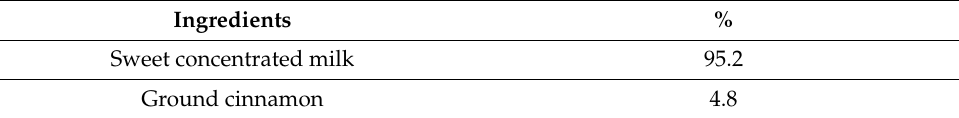
Table 3. Glaze ingredients of cinnamon